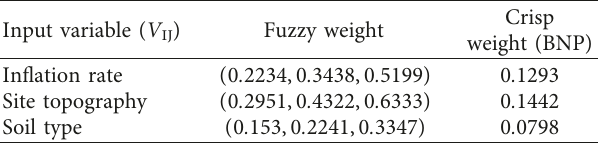
Table 6: The weight of input variables with respect to the variable group ( V 3 ). Input variable ( V IJ